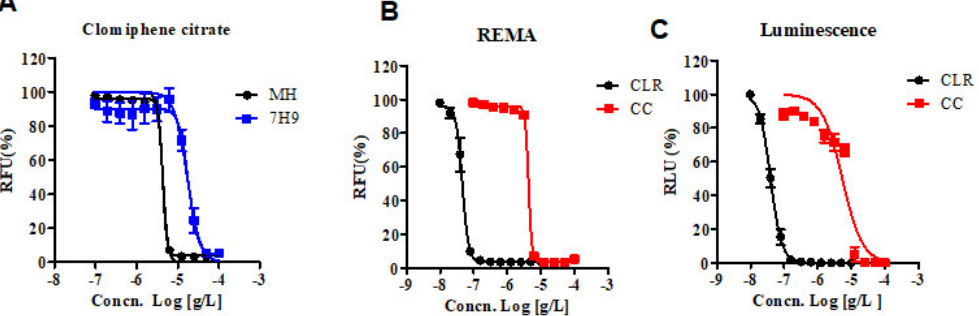
Figure 1. In vitro activity of CC. ( A ) The activity of CC against M. abscessus cultured in 7H9 broth with 10% OADC and cation-adjusted Mueller–Hinton medium (MH). ( B ) The activity of CC against M. abscessus in MH broth medium. Dose- response curves were plotted from the REMA. RFU, relative fluorescence units. CLR was used as a reference control. ( C ) The activity of CC against M. abscessus —Lux, incubated under the same condition as in panel B. RLU, relative luciferase units. The experiments were carried out with three biological replicates and expressed as the mean ± SEM for each concentration. This result was made from a representative experiment.